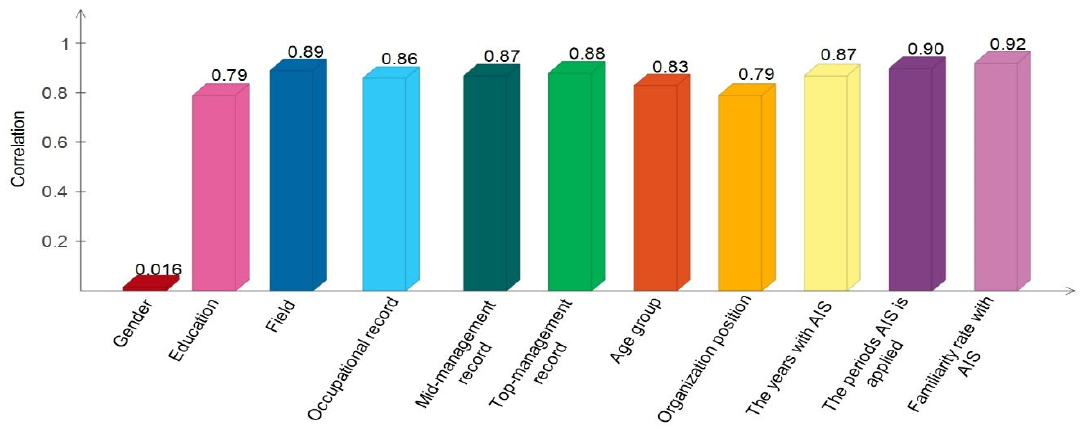
Figure 5. The correlation coefficient of the various characteristics.